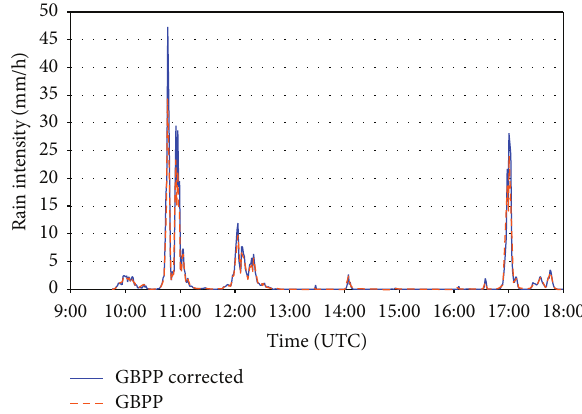
Figure 8: Rainfall intensities calculated with the sampling area uncorrected ( GBPP ) and corrected ( GBPP corrected